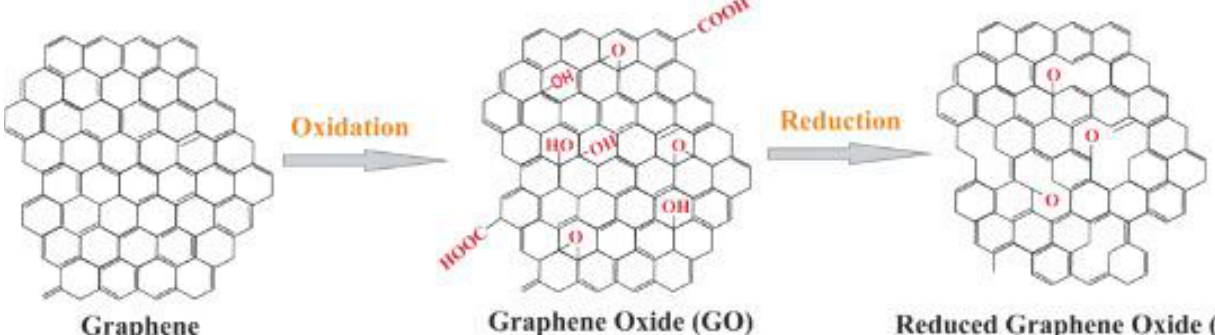
Figure 2. The conversion process of graphene to GO and rGO [28] .